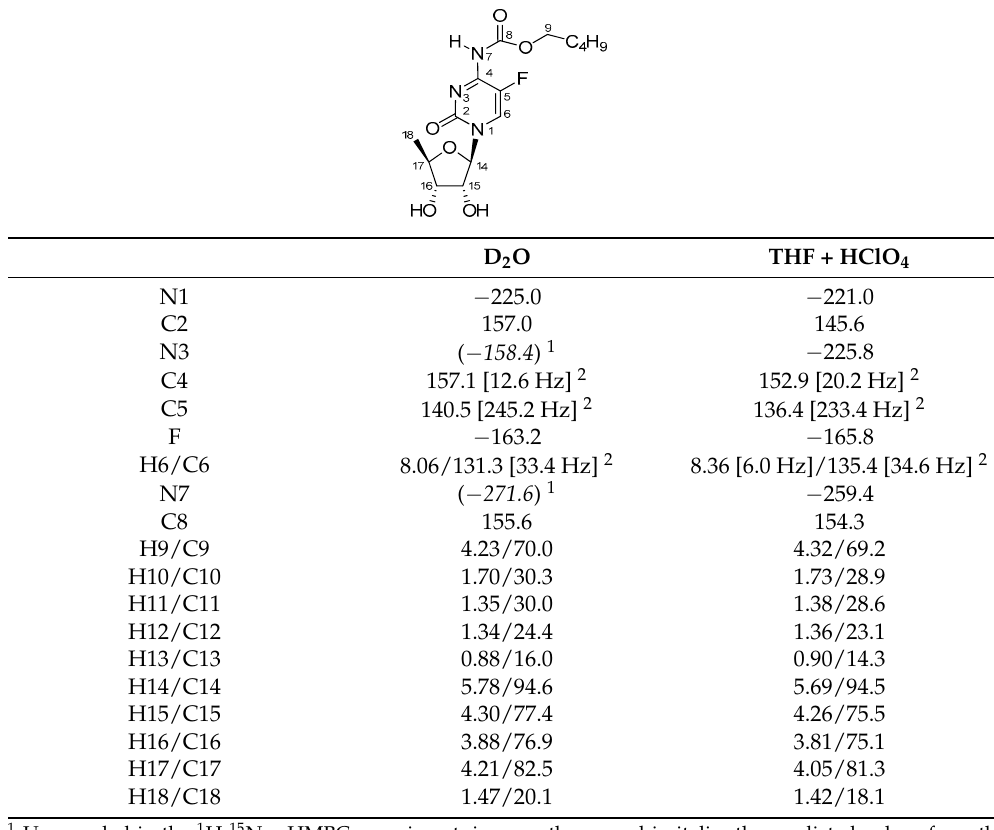
Table 3. The 1 H/ 13 C/ 15 N chemical shifts of capecitabine in H 2 O/D 2 O (298 K) and capecitabine acidified with HClO 4 in THF- d 8 (283 K).